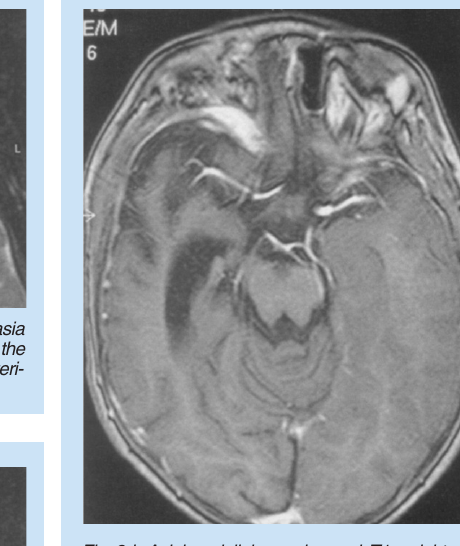
Fig 2d. Axial gadolinium-enhanced T1-weighted image showing dilation of the peritemporal sub- arachnoid space and temporal horn of the right lat- eral ventricle.